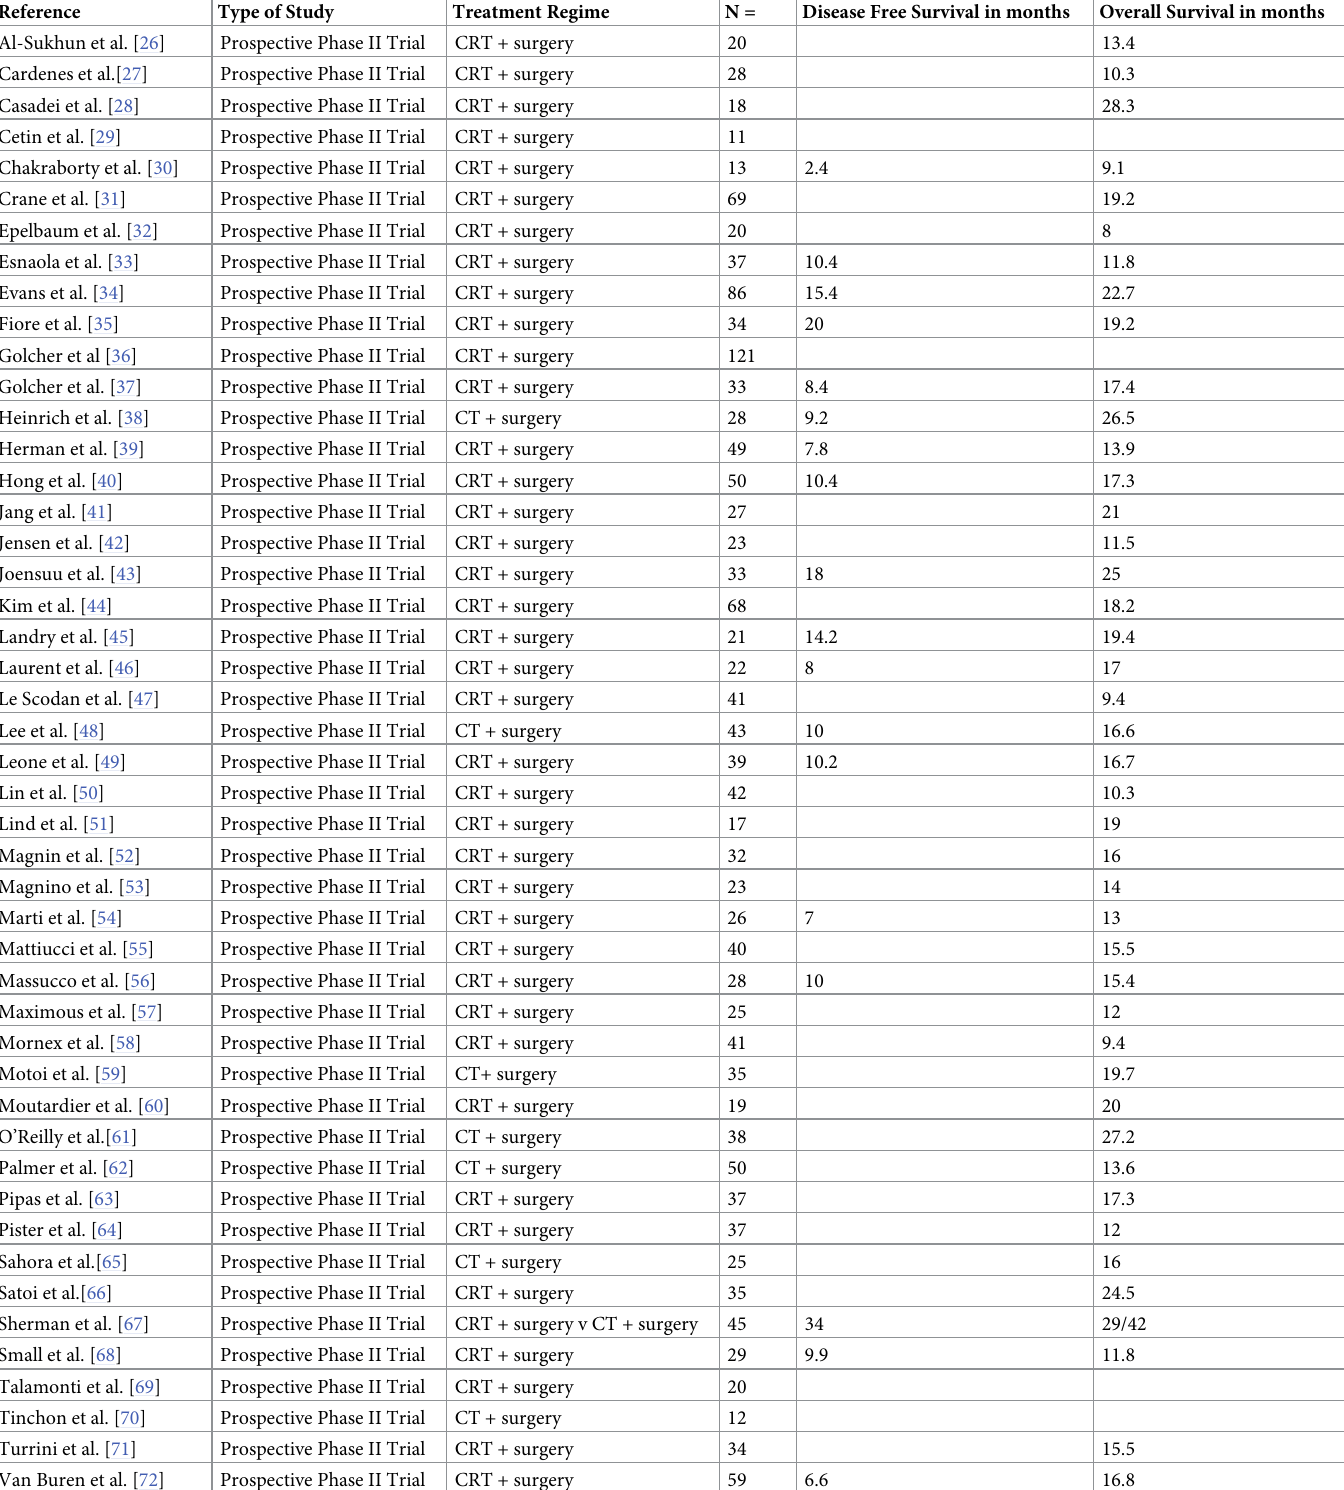
Table 1. Summary of included